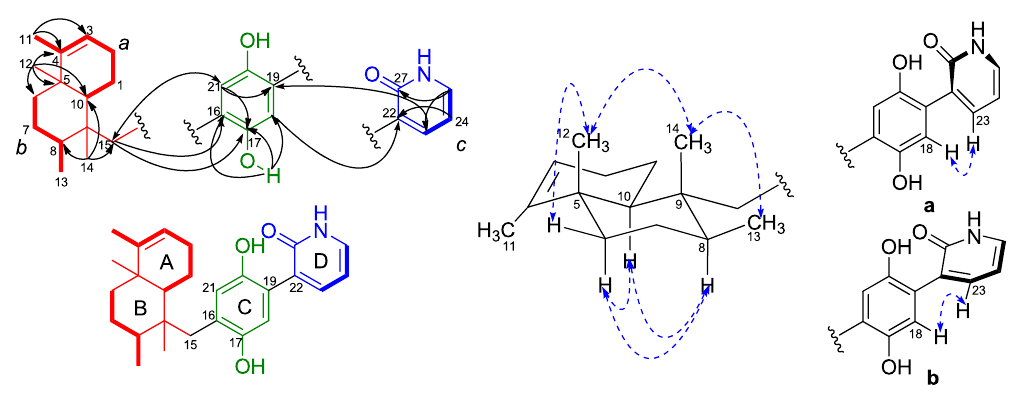
Figure 1. Structures of dysivillosins A–D ( 1 – 4 ).